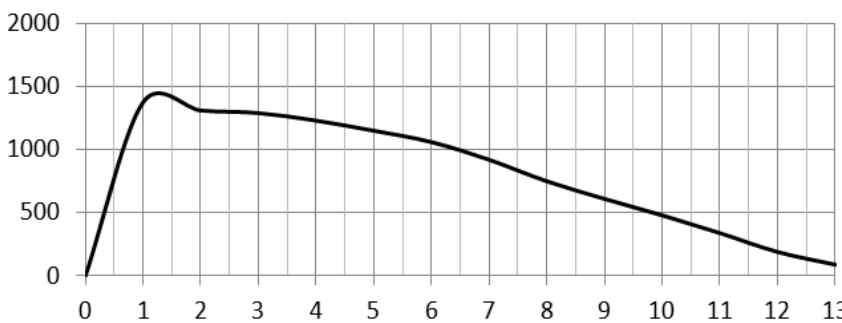
Fig. 2. A typical graph of the thermal energy release (kW) in a resistor unit during a braking cycle versus time